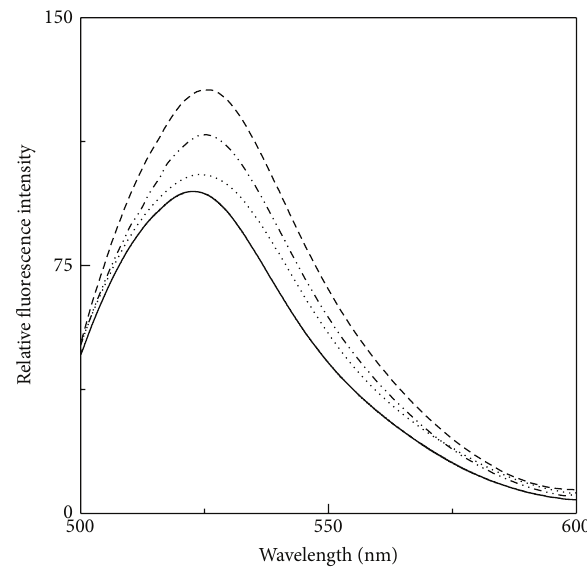
Figure 7: Fluorescence spectra of FITC-BSA at 25 ∘ C (—) and 70 ∘ C both in the absence (---) and presence of 10% (– ⋅ ⋅ –) and 20% ( ⋅ ⋅ ⋅⋅ ) (w/v)